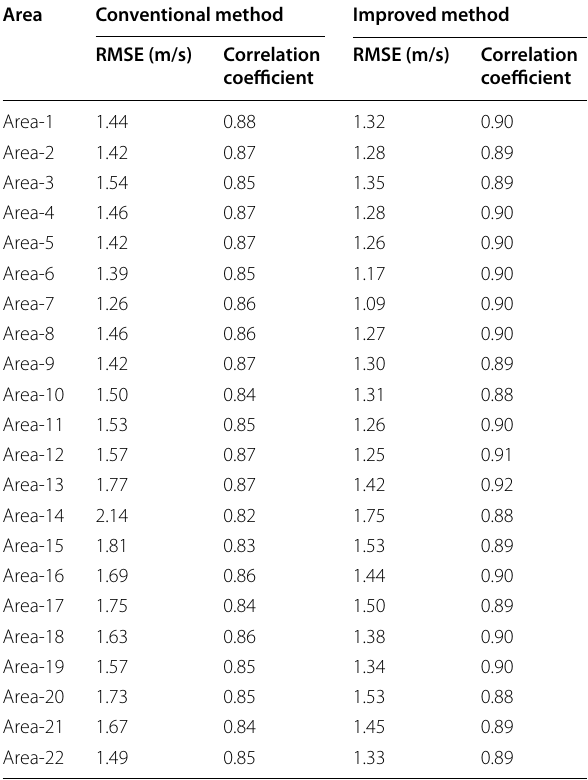
Table 2 The wind speed retrieval performance in each